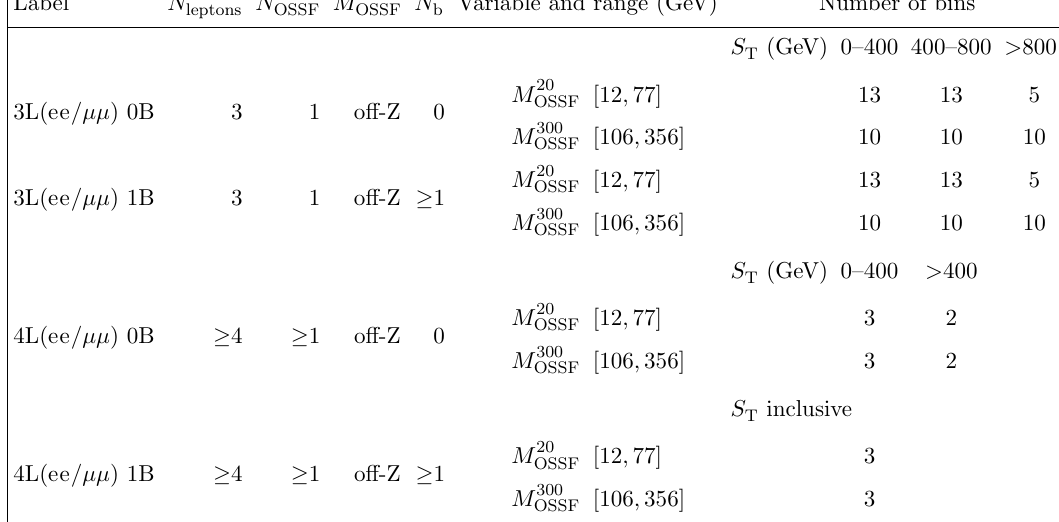
Table 2 . Multilepton signal region de(cid:12)nitions for the tt (cid:30) signal model. All events containing a same-(cid:13)avor lepton pair with invariant mass below 12 GeV are removed in the 3L and 4L event categories. Furthermore, 3L events containing an OSSF lepton pair with mass below 76 GeV